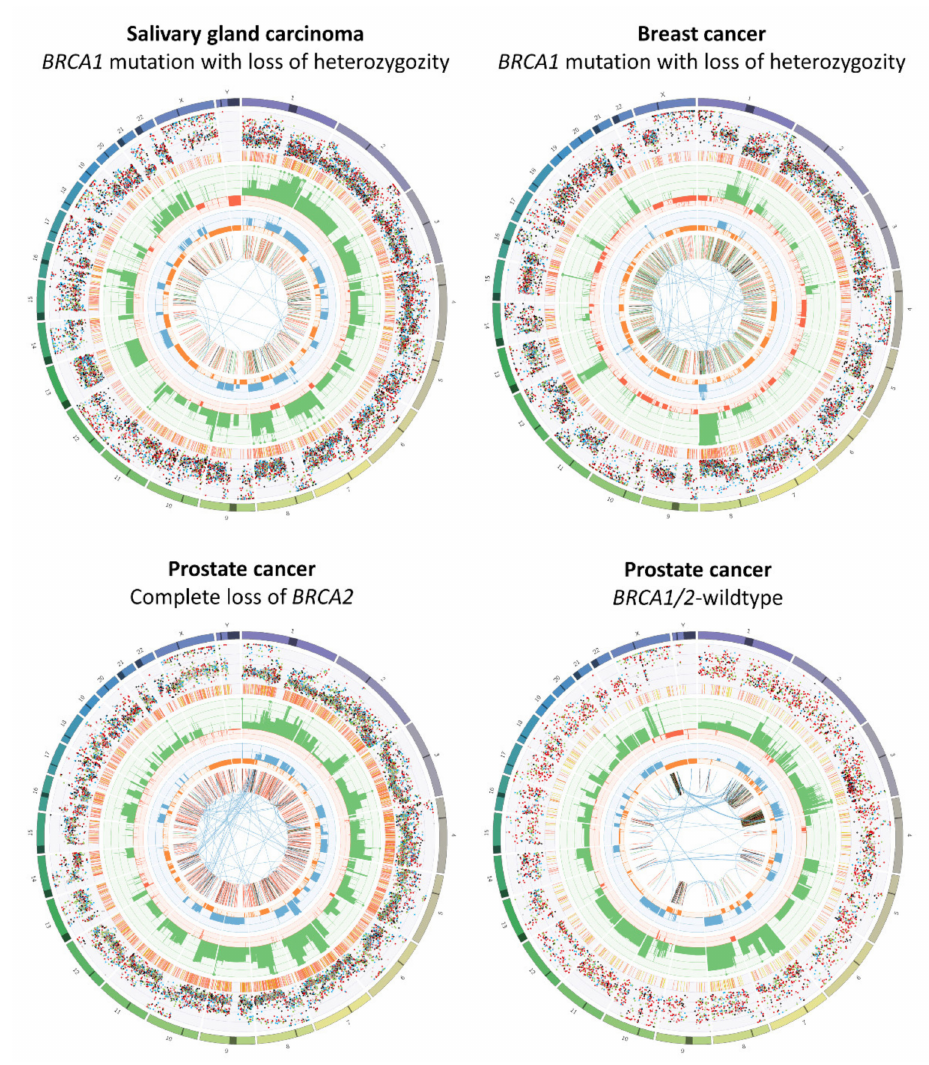
Figure 2. The genomic landscape of BRCA -mutated and BRCA -wildtype tumors. The depicted circos plots were generated using whole genome sequencing data of CPCT-02 study participants treated in the Radboudumc. Results of the CPCT-02 have previously been published elsewhere [30]. The outer first circle shows the chromosomes. The darker areas represent large gaps in the human reference genome, i.e., regions of centromeres. The second circle shows all somatic single nucleotide variants (SNVs) across the genome. Tumor purity-adjusted allele frequencies are scaled from 0% to 100%. SNVs are colored according to the type of base change in concordance with coloring used in previous literature [31]. Base substitutions that frequently occur in HRD are displayed in blue (C > A) and black (C > G). The third circle depicts short insertions (yellow) and deletions (red, indels). The fourth circle shows all copy number changes. Losses and gains are indicated in red and green, respectively. The scale ranges from 0 (complete loss) to 6 (high-level gains). Absolute copy numbers above 6 are indicated by a green dot on the diagram. The fifth circle represents the observed minor allele copy numbers. The scale ranges from 0 to 3, with losses (<1) shown in orange and gains (>1) shown in blue. The innermost circle displays the structural variants within or between the chromosomes. Translocations are indicated in blue, deletions are indicated in red, insertions are shown in yellow, tandem duplications are indicated in green, and inversions are shown in black. The figure shows that BRCA -mutated tumors generally have higher numbers of SNVs, small indels, deletions, and tandem duplications (the latter is only more frequent in BRCA1 -mutated